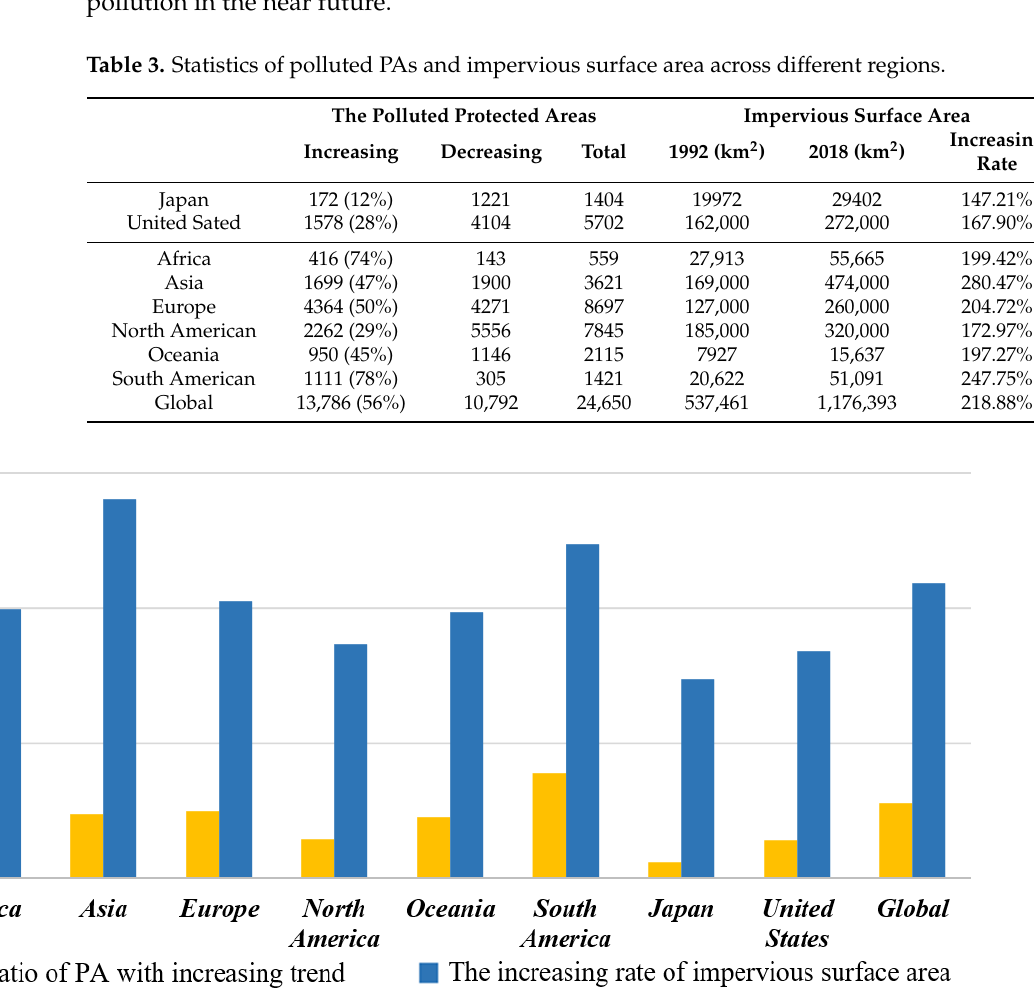
Table 3. Statistics of polluted PAs and impervious surface area across different regions.